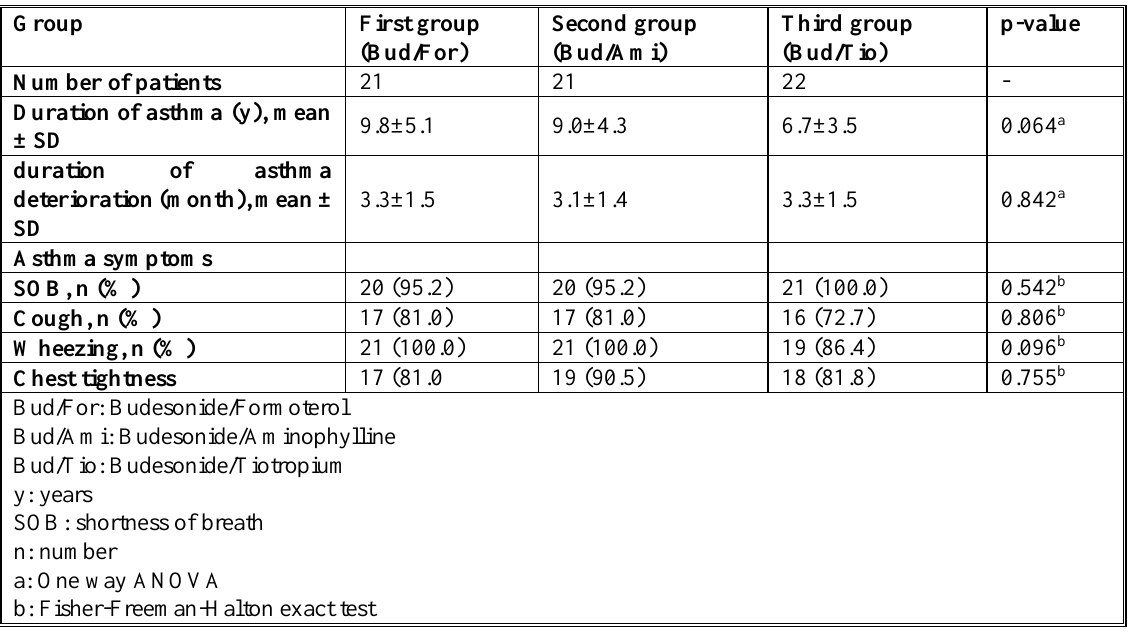
Table 2. Comparison of baseline asthma characteristics between the study groups. Group First group (Bud/For) Number of patients